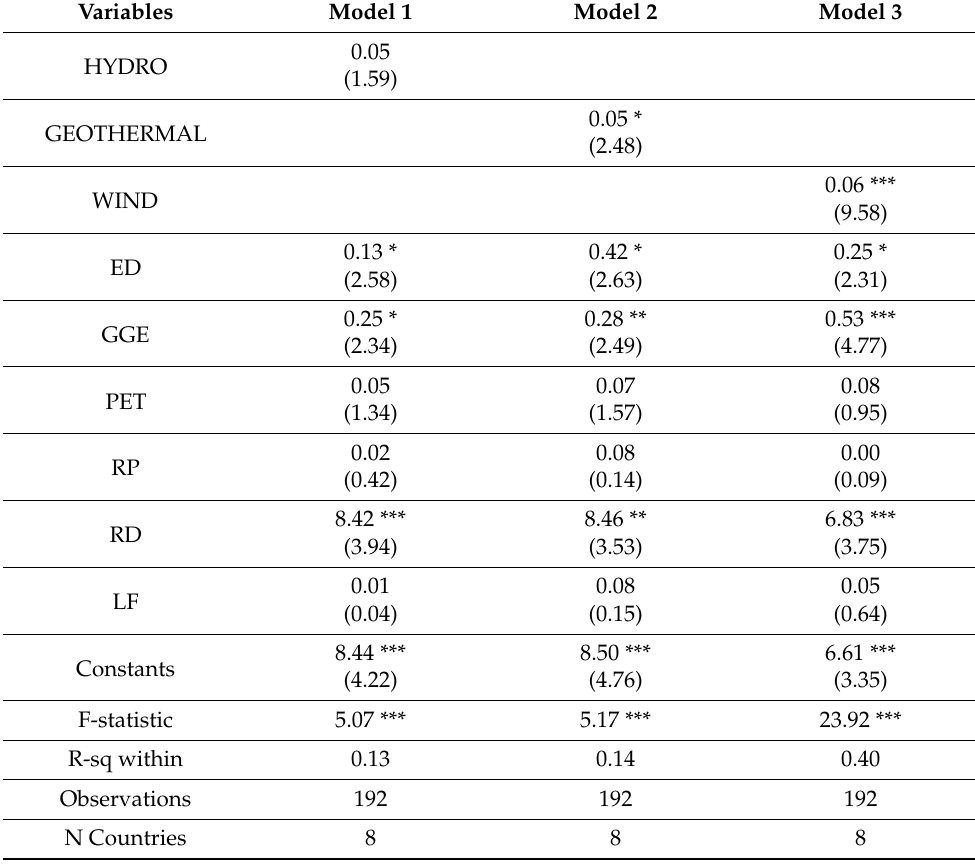
Table 6. Estimation of Fixed-effects model regarding hydropower energy, geothermal energy, and wind energy sources on economic growth sustainability.